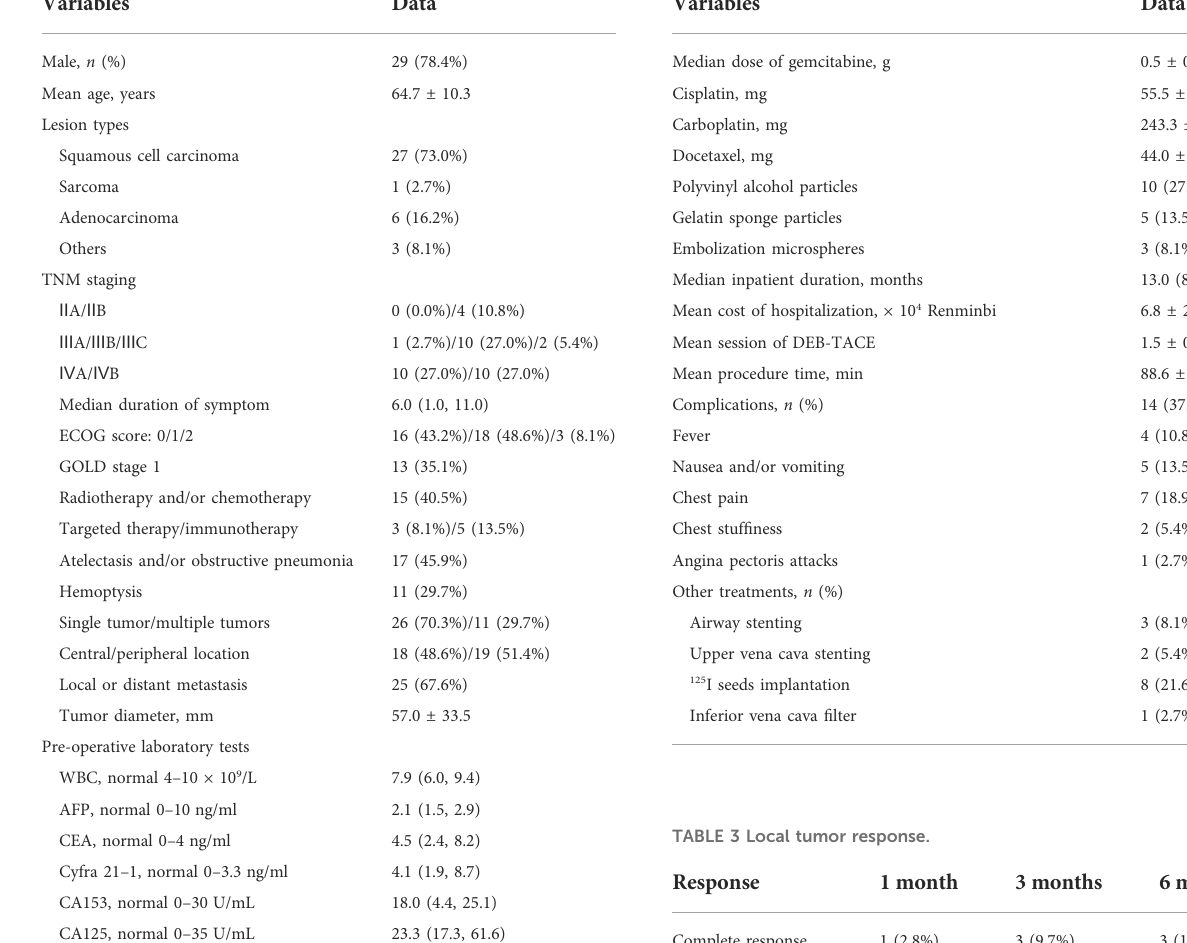
TABLE 1 Patient characteristics at admission. TABLE 2 Clinical data on DEB-TACE.